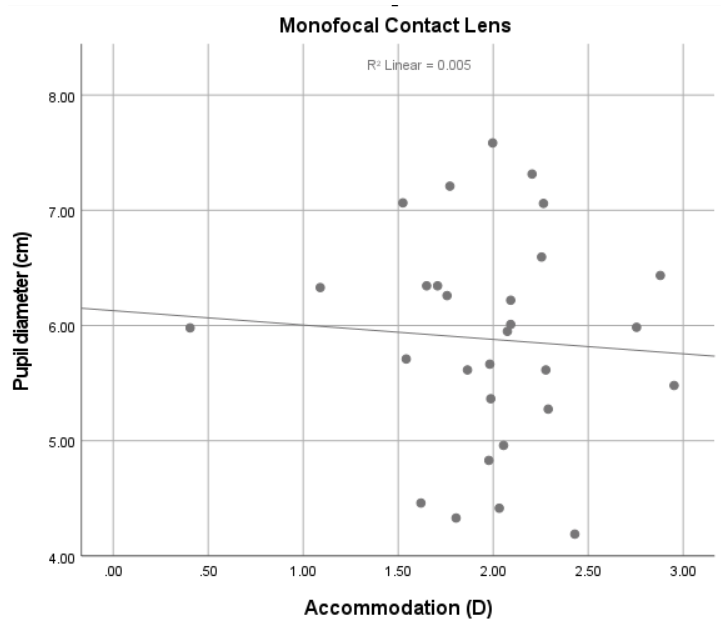
Figure 4. Change of pupil size with accommodation.